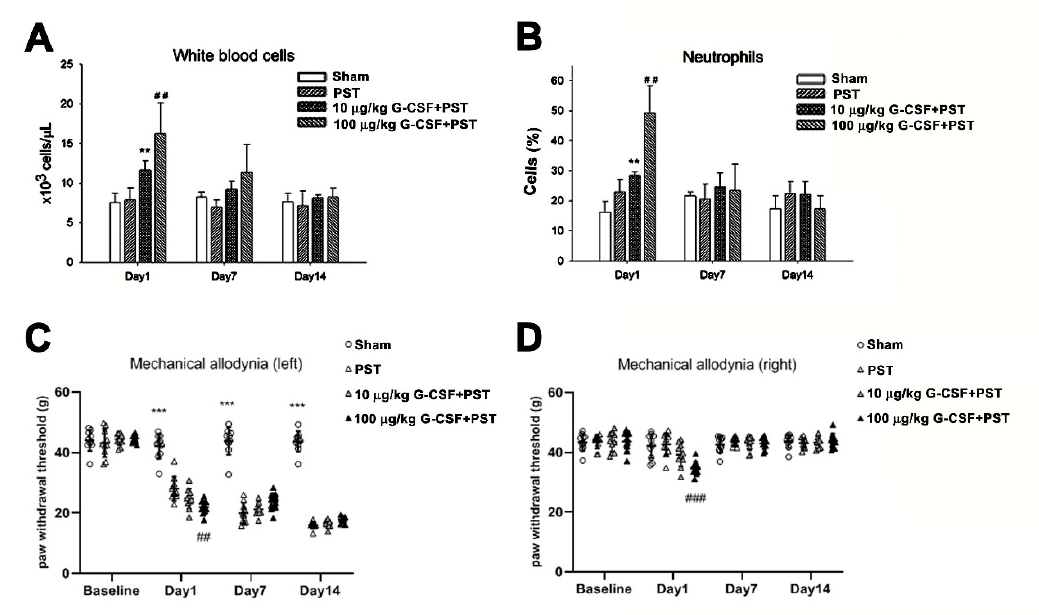
Figure 5. Effect of exogenous G-CSF on PST-induced rat behavior and blood analysis. ( A ) Histograms showing the results of white blood cell analysis (×10 3 cells/ μ L) in the sham group, PST group, G-CSF (10 μ g/kg) +PST group and G-CSF (100 μ g/kg) + PST group. White blood cell analysis was performed with a Bayer ADVIA 2120 hematology analyzer. ** p < 0.01, G-CSF (10 μ g/kg) + PST group compared with the PST group; ## p < 0.01, G-CSF (100 μ g/kg) + PST group compared with the PST group. ( B ) Histograms showing the results of neutrophil analysis in the 4 groups of rats. Neutrophil analysis was performed with a Bayer ADVIA 2120 hematology analyzer. ** p < 0.01, G-CSF (10 μ g/kg) + PST group compared with the PST group; ## p < 0.01, G-CSF (100 μ g/kg) + PST group compared with the PST group. Left ( C ) and right ( D ) paw withdrawal test for mechanical allodynia. Pain behavioral responses of the 4 groups rats (n = 10 per group). Mechanical allodynia was assessed using a DPA. (C) Pain behavior on the left side, ## p < 0.01, G-CSF (100 μ g/kg) + PST group, compared with the PST group. *** p < 0.001, PST and G-CSF+PST groups, compared with sham group. (D) Pain behavior on the right side, ### p < 0.001, G-CSF (100 μ g/kg) + PST group compared with the PST group.